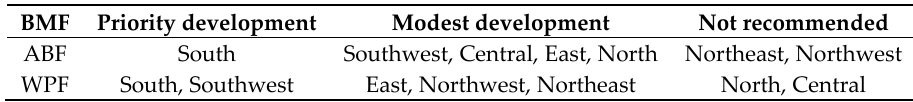
Table 9. Development strategy of BMF for each